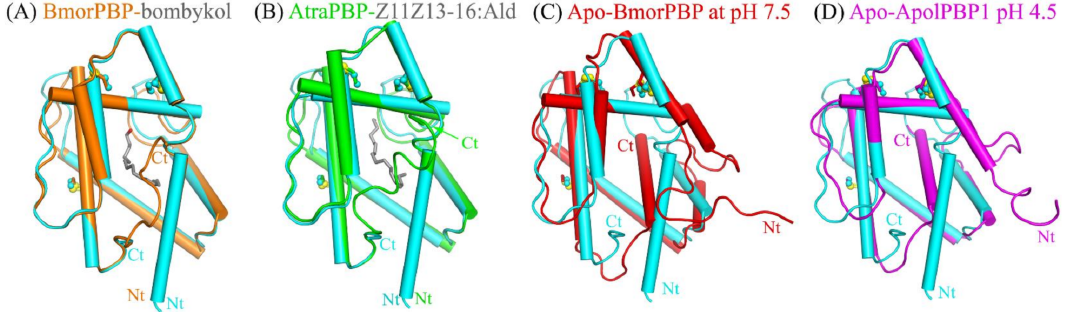
Figure 2. Superimposition of apo-HarmPBP1 (cyan) on selected OBPs. ( A ) BmorPBP-bombykol (PDB: 1DQE, orange). ( B ) AtraPBP- Z 11 Z 13-16:Ald (PDB: 4INW, green). ( C ) apo-BmorPBP at pH 7.5 (PDB: 2FJY, red). ( D ) Apo-ApolPBP1 at pH 4.5 (PDB: 2JPO, magenta). Conserved disulfide bonds (yellow) are shown in ball-stick modes. Ligands,